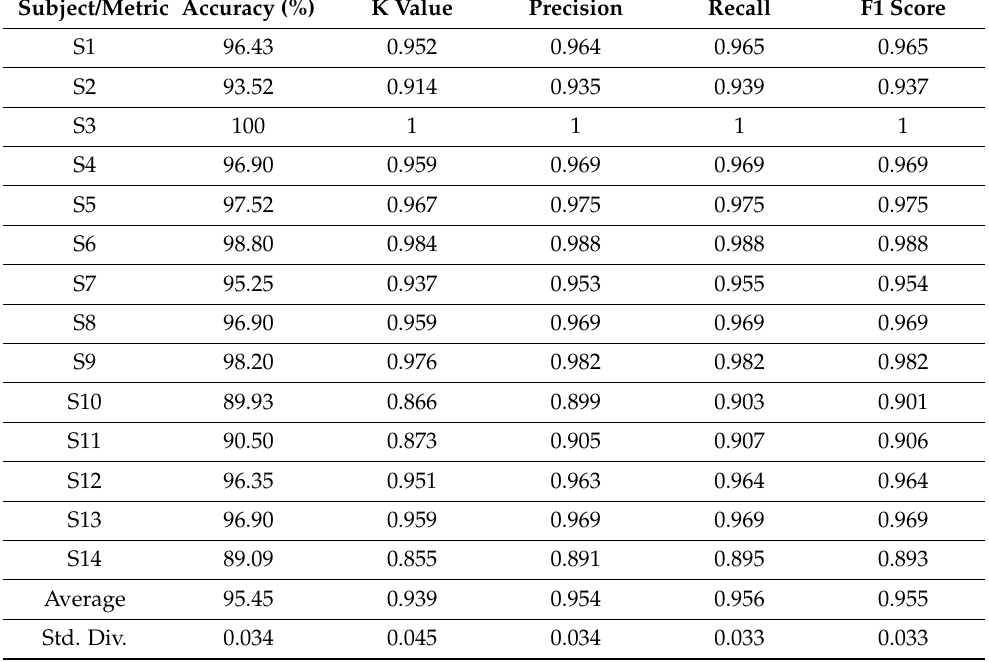
Table 5. Performance metrics on the HGD dataset using the MBEEGCBAM.